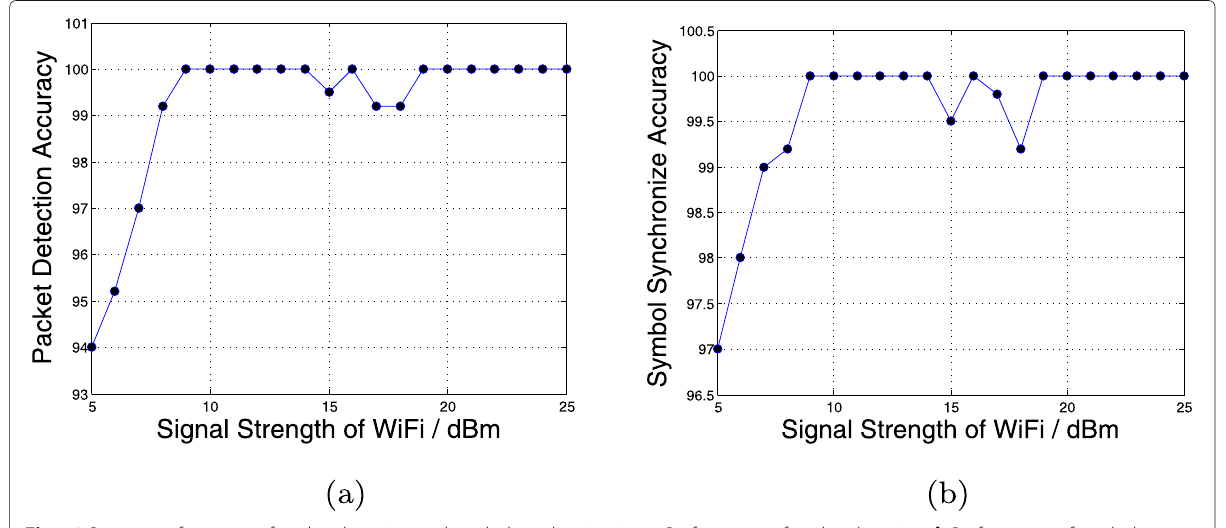
Fig. 18 System performance of packet detection and symbol synchronization. a Performance of packet detection. b Performance of symbol